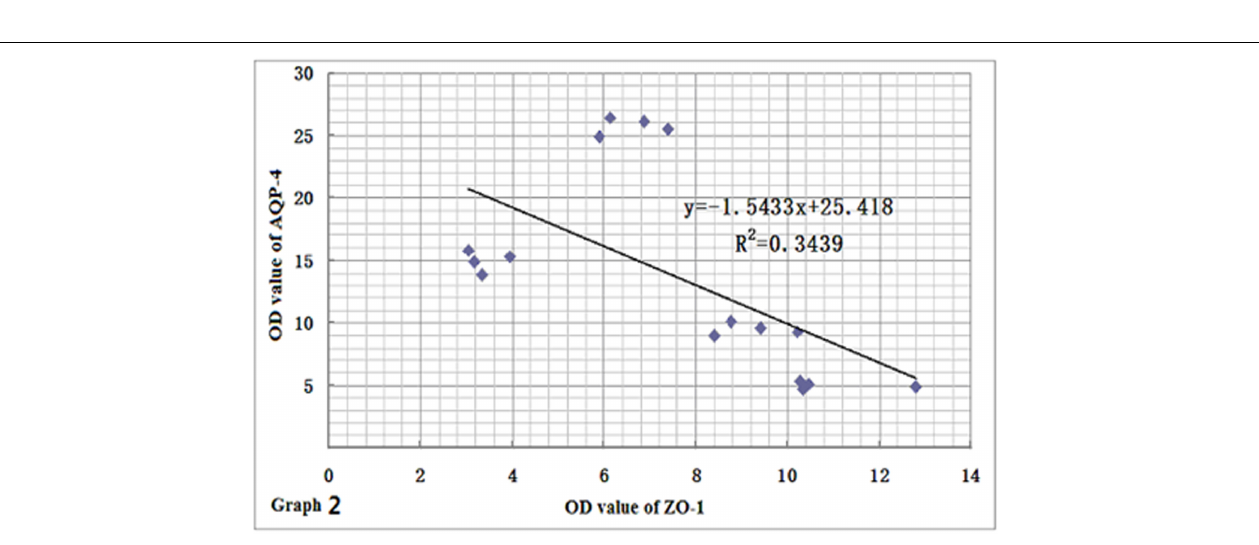
FIGURE 10 | Relationship between ZO-1 and AQP-4 protein expressions. AQP-4 expression differed slightly from the fluctuation of ZO-1 protein, and there may exist negative correlation between the two proteins to some extent ( n = 4, r = − 0.5864).